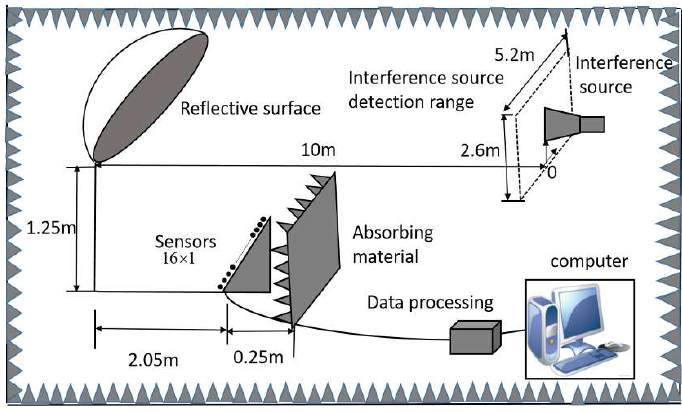
Figure 9. Settings of the electromagnetic imaging system experiment.